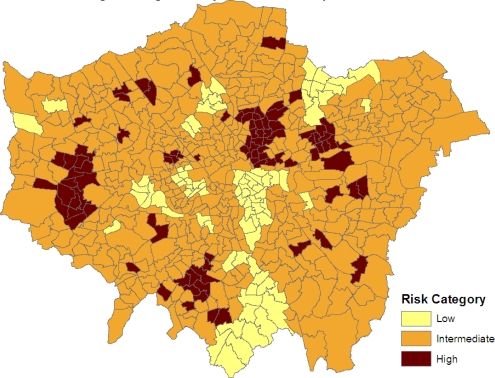
Significantly elevated and depressed risk.